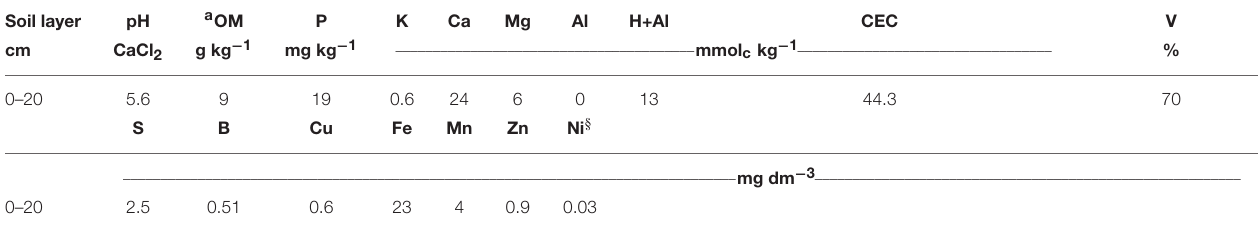
a OM, determined by the total carbon content of the soil according method proposed of Walkey–Black (Van Raij et al., 2001); P, K, Ca, and Mg, extraction with ion exchange resin (Cantarella et al., 1998; Van Raij et al., 2001); Al extracted with 1 N KCl (Van Raij et al., 2001); H + Al determined by SMP buffer solution (Quaggio et al., 1985); CEC, Cation exchange capacity; V, bases saturation. § Ni, DTPA pH